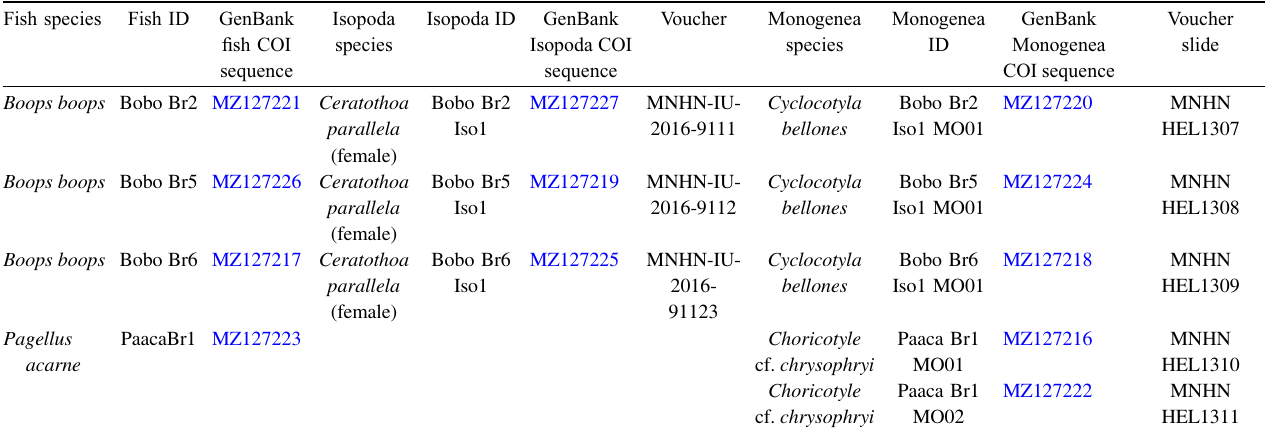
Table 2. Fishes, Isopoda, Monogenea, and their COI sequences. To ensure full traceability and respect of host-parasite relationships, for Cyclocotyla bellones one monogenean was collected from one parasitic isopod and each fi sh, isopod and monogenean individuals were sequenced. Choricotyle chrysophryi is a parasite of the fi sh, so no isopod was involved. All vouchers were deposited in the